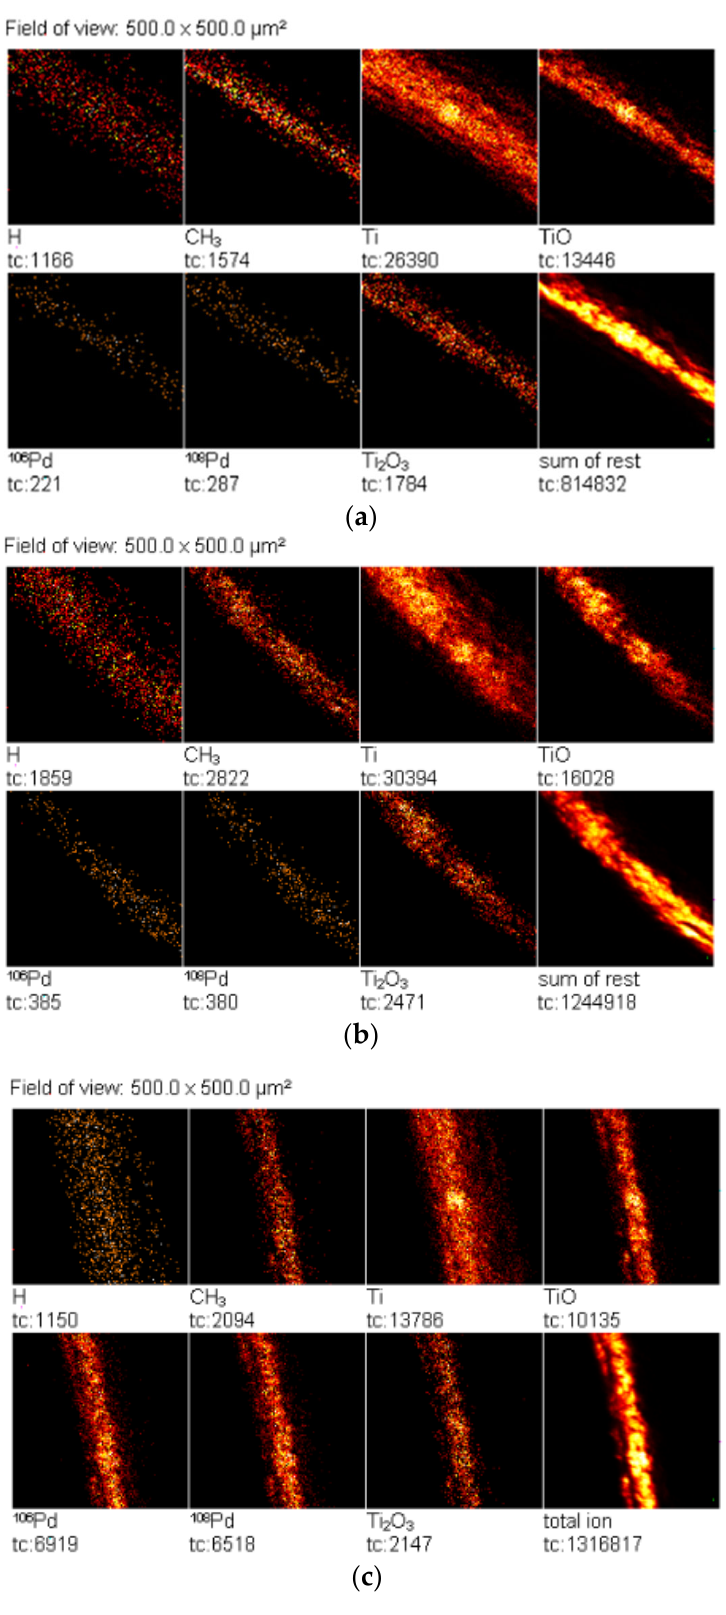
Figure 14. TOF-SIMS images of the surfaces of Pd/TiO 2 catalysts obtained from solutions containing ( a ) 0.02, ( b ) 0.2, and ( c ) 2% of Pd. The ion count (tc) of secondary ions is shown under each image.